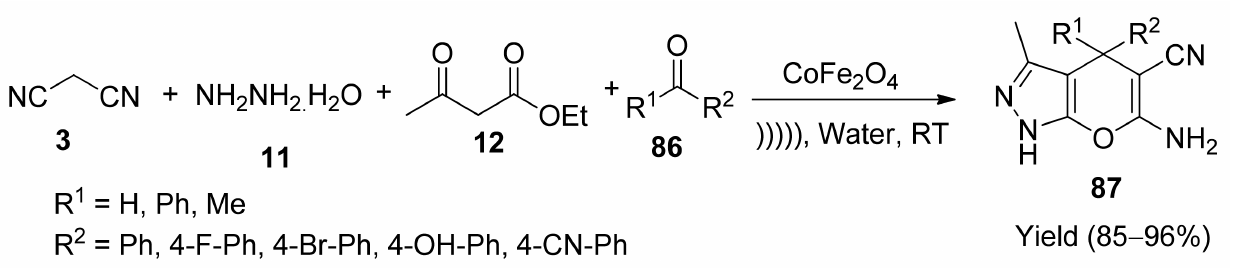
Scheme 25. Synthesis of pyranopyrazole derivatives 87 using CoFe 2 O 4 .